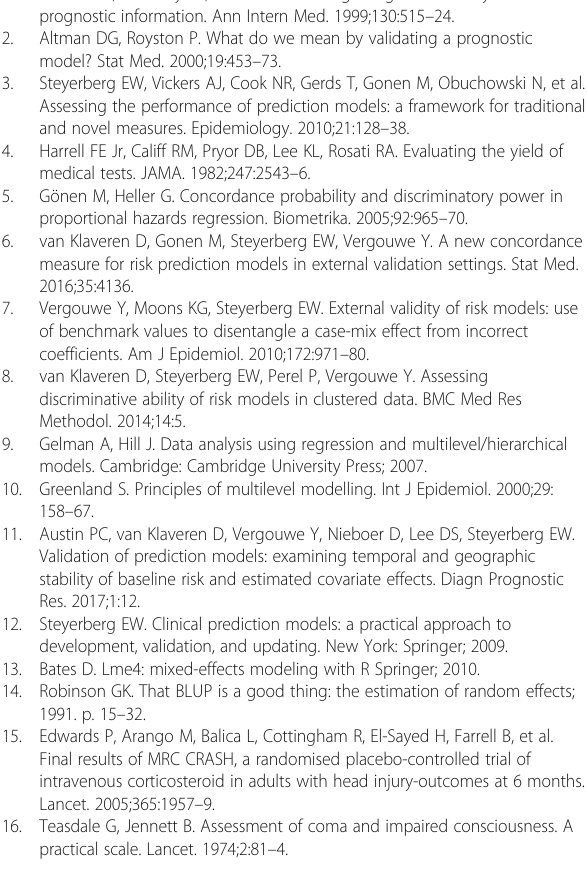
Additional file 1: Table S1. Cluster sizes and performance measures across 19 European centers of the CRASH trial. Table S2. Cluster sizes and performance measures at external validation across 36 non-European centers of the CRASH trial. Table S3. Simulation characteristics (2000 replications) of c-index and c-mbc across 40 centers of 200 patients without between center heterogeneity in intercept and slope. Table S4. Simulation characteristics (2000 replications) of c-index and c-mbc across 40 centers of 400 patients. Table S5. Simulation characteristics (2000 replications) of c-index and c-mbc across 40 centers of 200 patients when the regression model was misspecified. Table S6. Simulation characteristics (2000 replications) of c-index and c-mbc across 40 centers of 200 patients when the calibration slopes were not normally distributed. (DOCX 92